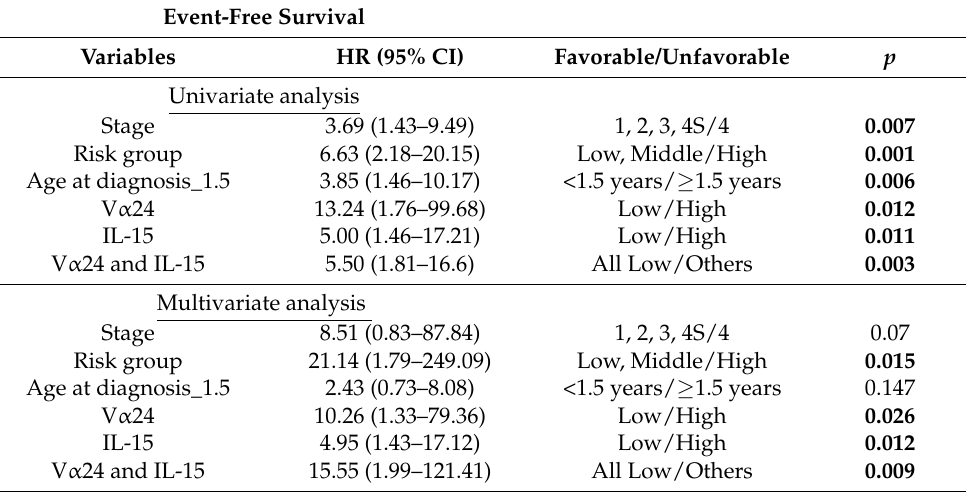
Table 3. Cox regression analyses of the various factors associated with overall survival in NBL patients ( n = 53).